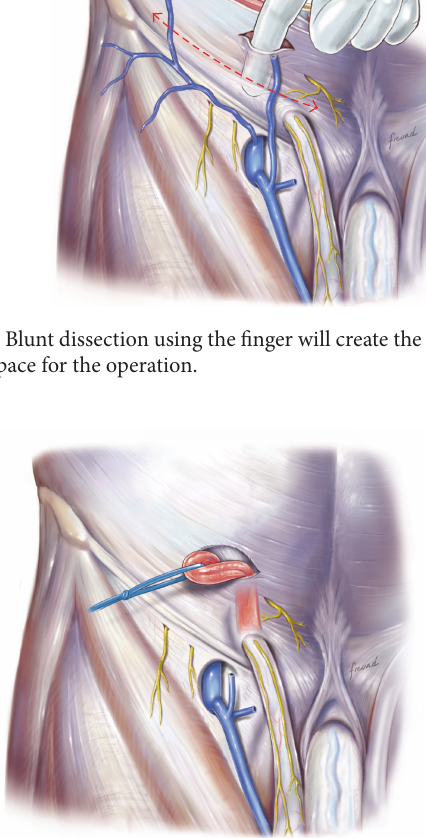
Figure 5: The cord is dissected and lifted out of the incision.